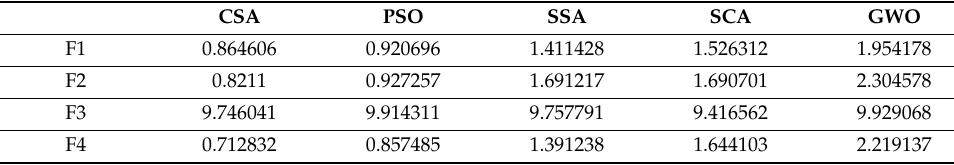
Table 11. CPU time for high-dimensional functions at d =